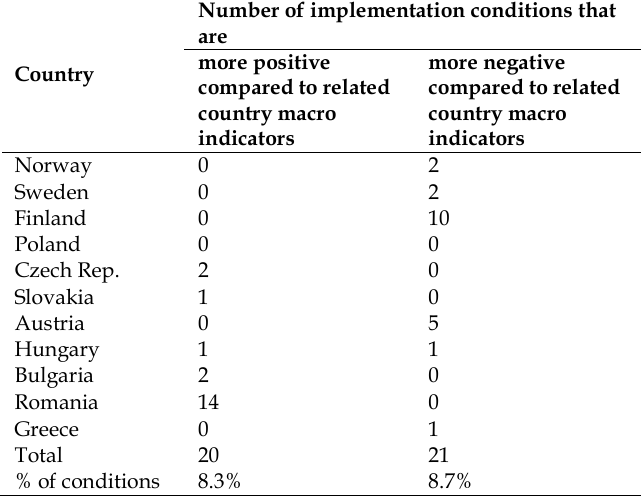
Table 8. Number of scores for implementation conditions that are not explained by the statistical